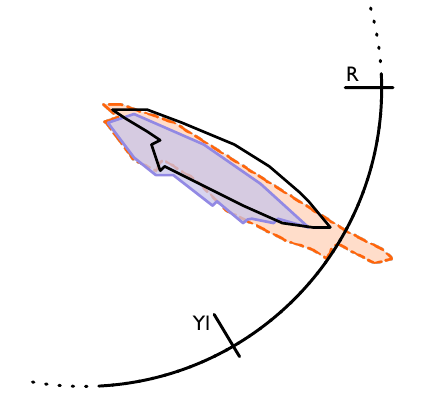
Figure 10 shows a vectorscope of the environmental light compensation depicted in Fig. 1. Black is the vectorscope of the bust for the original projection without environmental light. When opening the shades, warm, yellow environmental light is added. The orange segment (dashed outline) in the scope represents our